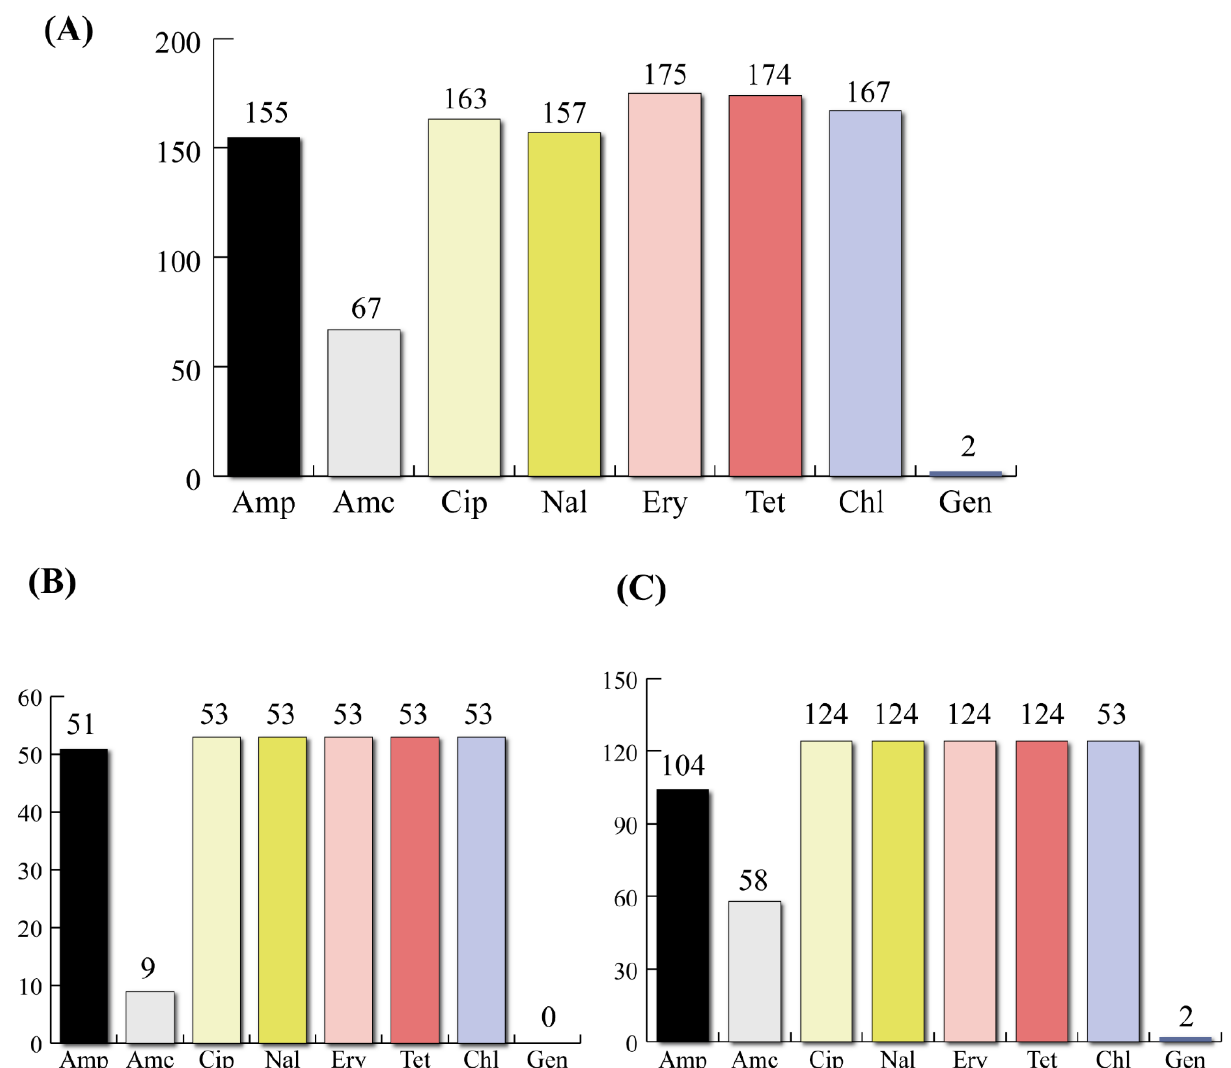
Figure 2. Antibiotic resistance distribution (number of resistant isolates) across Campylobacter isolates ( n = 177). Antibiotic resistance distribution in all Campylobacter isolates ( A ), in C. coli ( n = 53) ( B ), and in C. jejuni ( n = 124) ( C ).